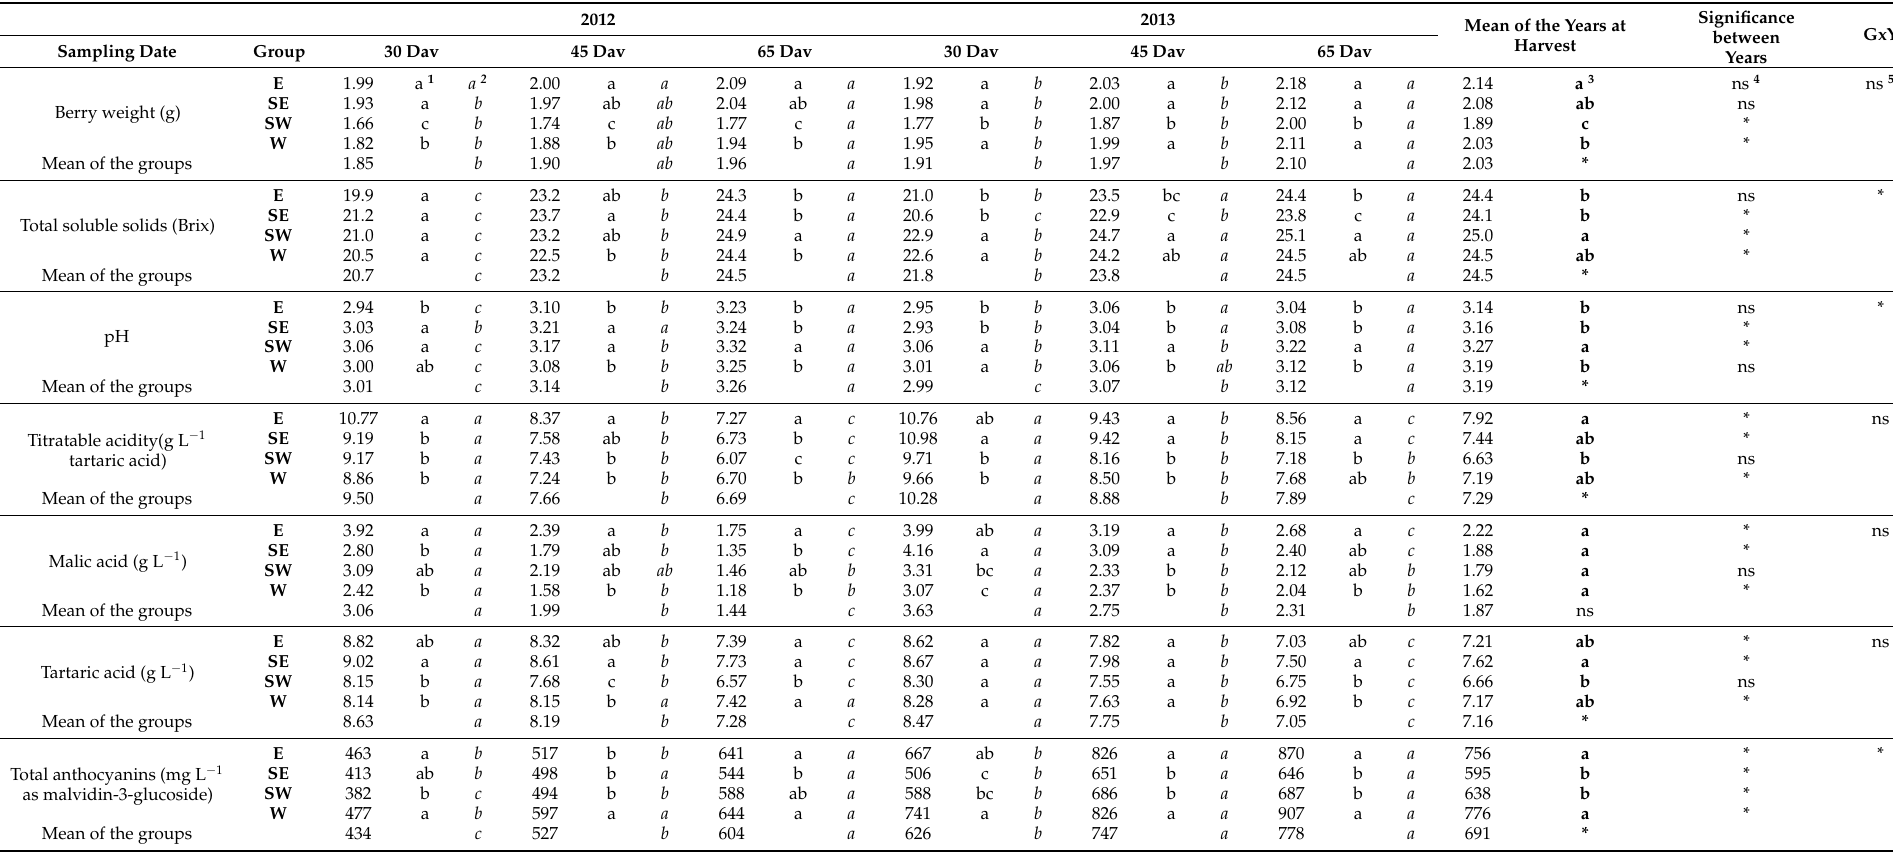
Table 3. Berry weight and must quality parameters assessed on 30, 45, 65 days after veraison (dav) in 2012 and 2013, and average value of the two years at harvest. GxY = interaction